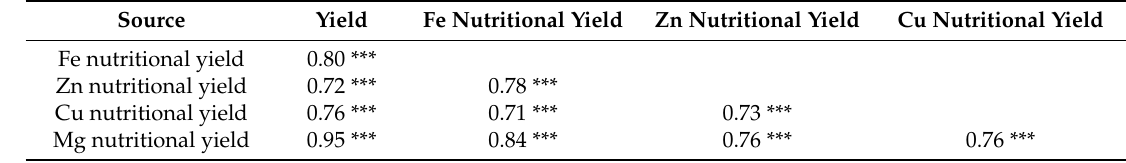
Table 3. Pearson correlation coefficients among yield and nutritional yield for Fe, Zn, Cu, and Mg.